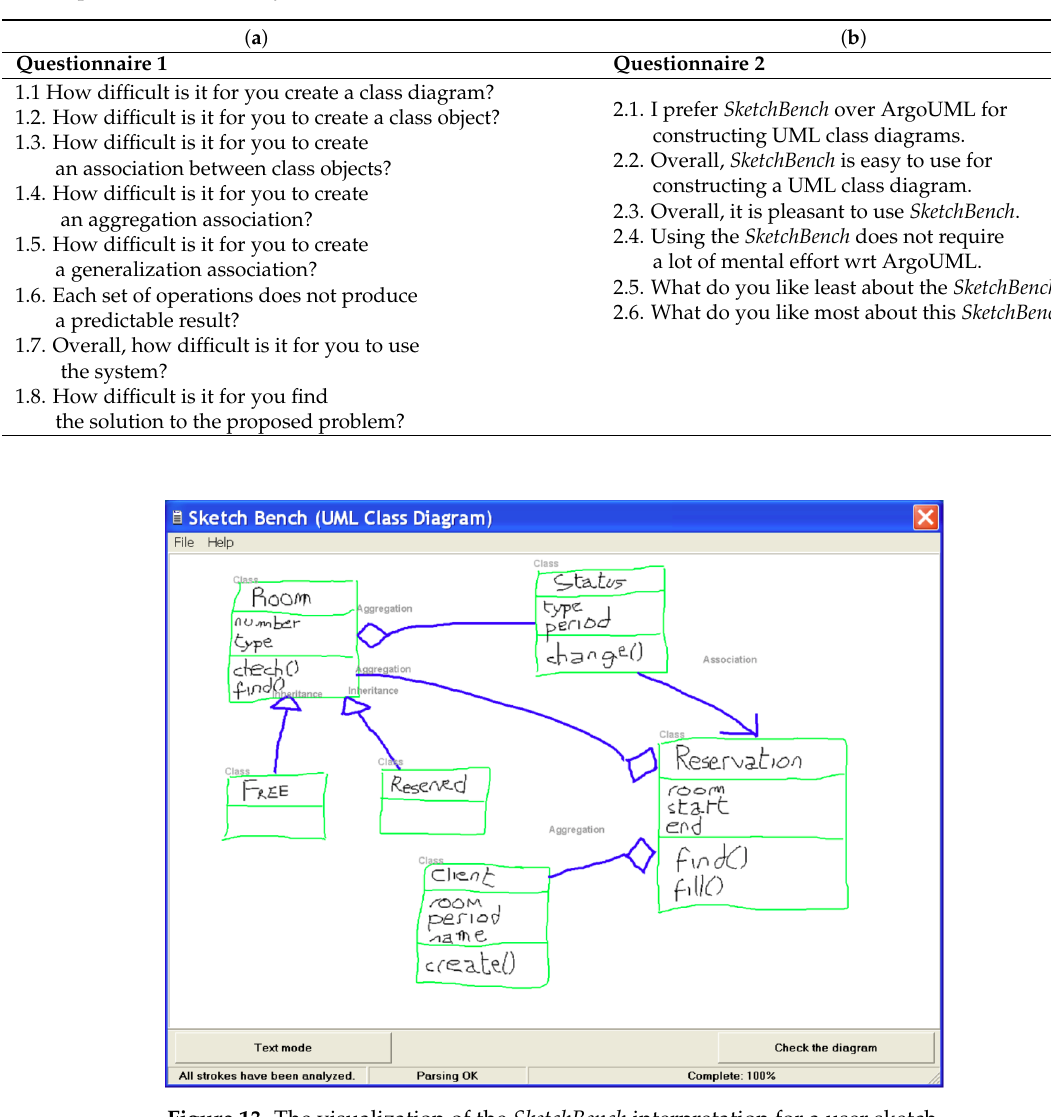
Figure 13. The visualization of the SketchBench interpretation for a user